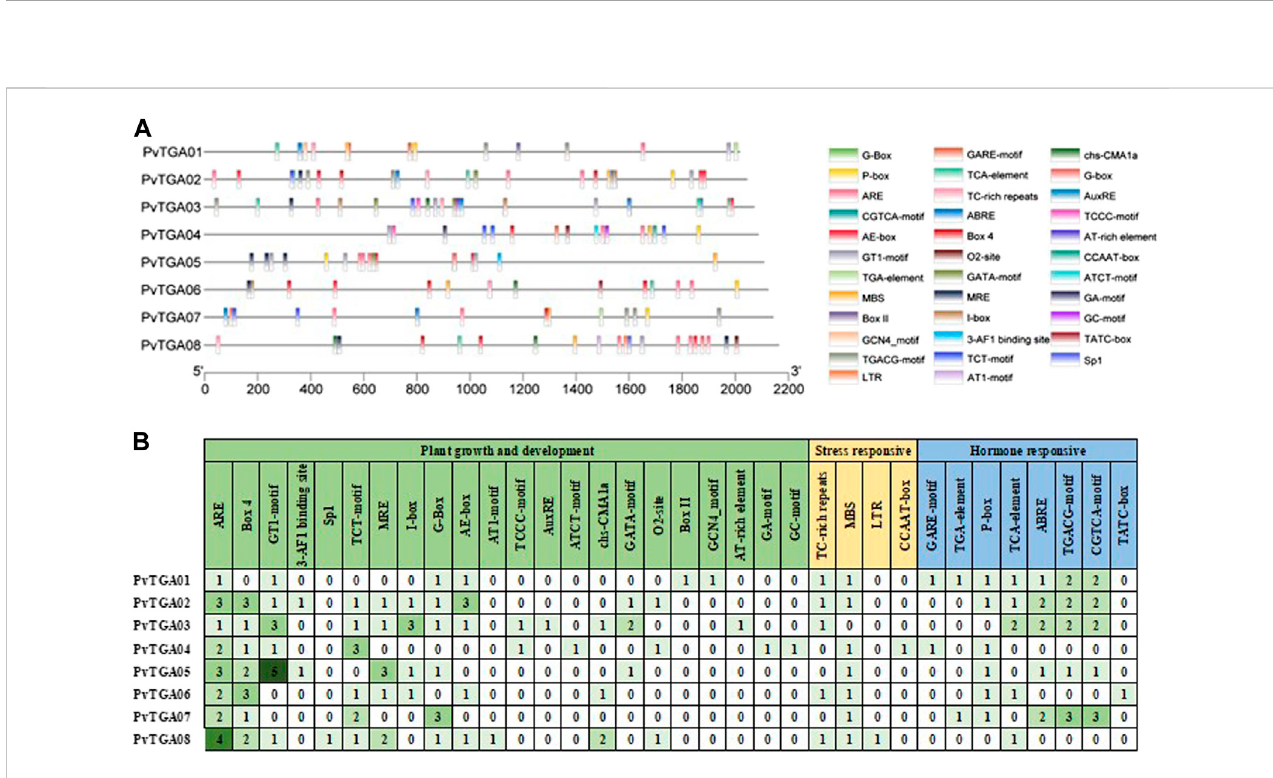
FIGURE 5 Analysis of the cis -acting elements in the promoter regions of 8 TGA genes. (A) the cis -acting elements distribution in 8 TGA genes promoters. Diverse colors were used for representing different cis -elements, as given in on the right side., (B) the names and numbers of cis-acting elements in 8 TGA genes promoters. The heatmap in grid and the color columns indicated the numbers of cis -acting